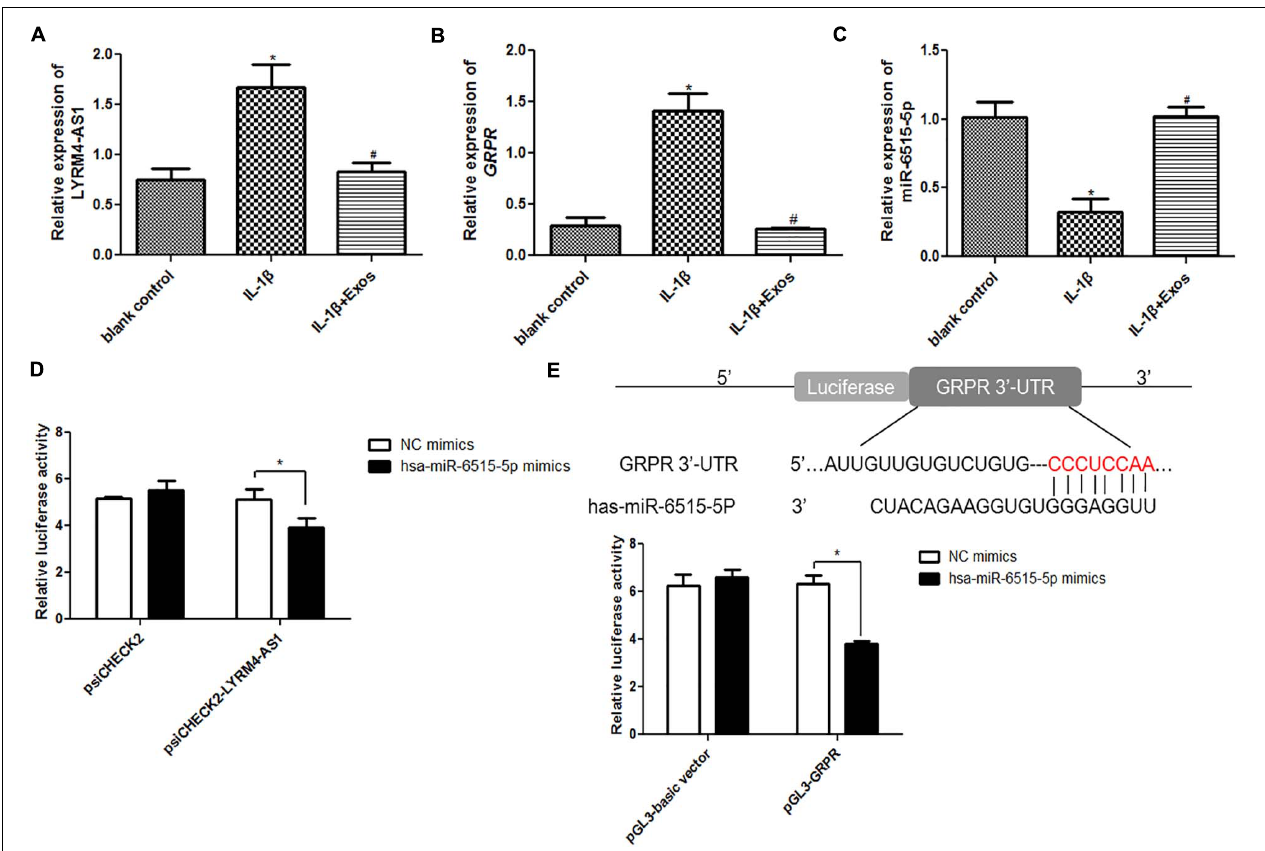
FIGURE 5 | The relative expression of lncRNA LYRM4-AS1 (A) , mRNA GRPR (B) , and miR-6515-5p (C) in the blank control group, IL-1 β group, and IL-1 β + Exo group. n = 3. * P < 0.05 vs. blank control group; # P < 0.05 vs. IL-1 β group. (D) LncRNA LYRM4-AS1 interacted with miR-6515-5p. n = 3. * P < 0.05 vs. negative control (NC) mimics. (E) GRPR directly binds with miR-6515-5p. n = 3. * P < 0.05 vs. NC